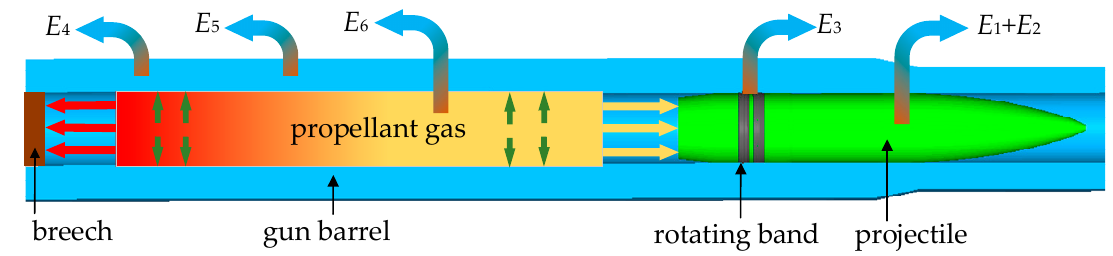
Figure 4. Schematic representation of the energy conversion process.